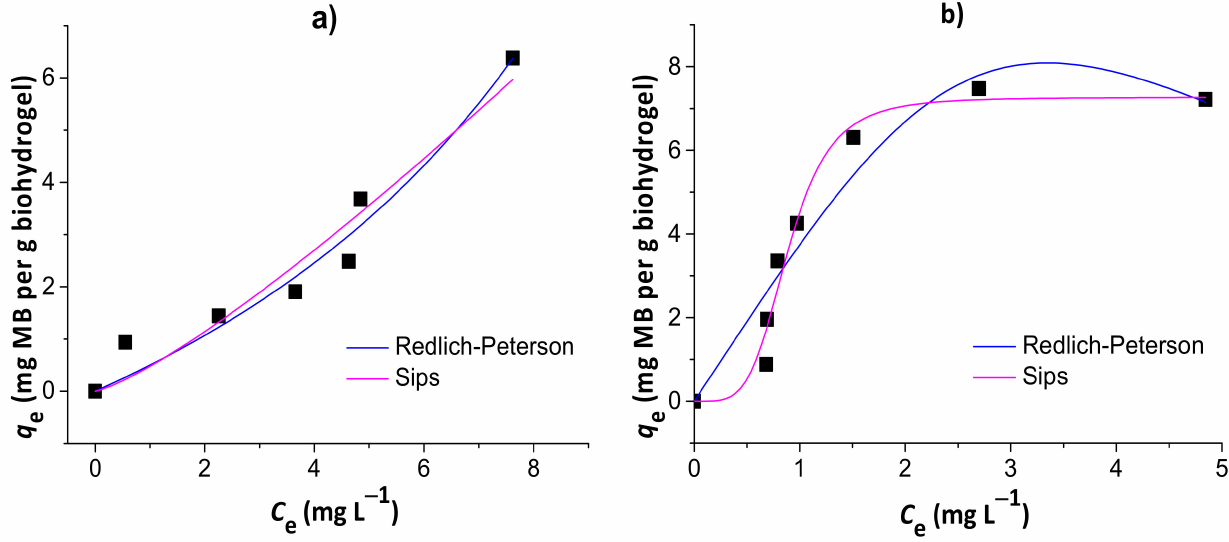
Figure 8. Results of nonlinear Redlich–Peterson and Sips isotherm models for the adsorption of MB to the chitosan/pectin ( a ) and chitosan/DNA ( b ) blend